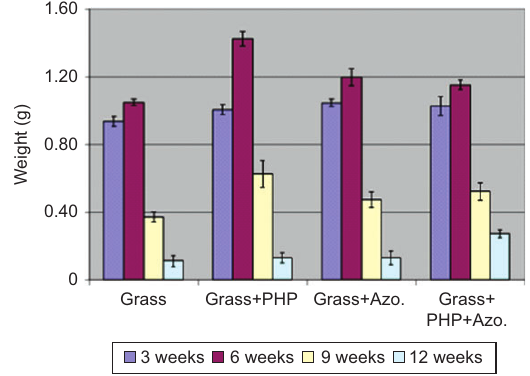
Figure 2 Grass yield under different soil treatment conditions with harvests carried out after 3, 6, 9 and 12 weeks. Treatment 1, grass only; treatment 2, grass + PHP; treatment 3, grass + Azospirillum brasilense ; treatment 4, grass + PHP with A. brasilense